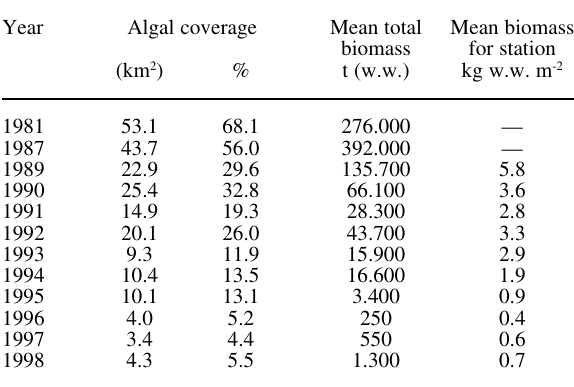
T ABLE 1. – Sequence of biomass and algal coverage from 1981 to 1998. Data of 1981 (Solazzi et al ., 1981) and 1987 (Sfriso et al ., 1992a) were re-analysed for present study area of 78 km 2